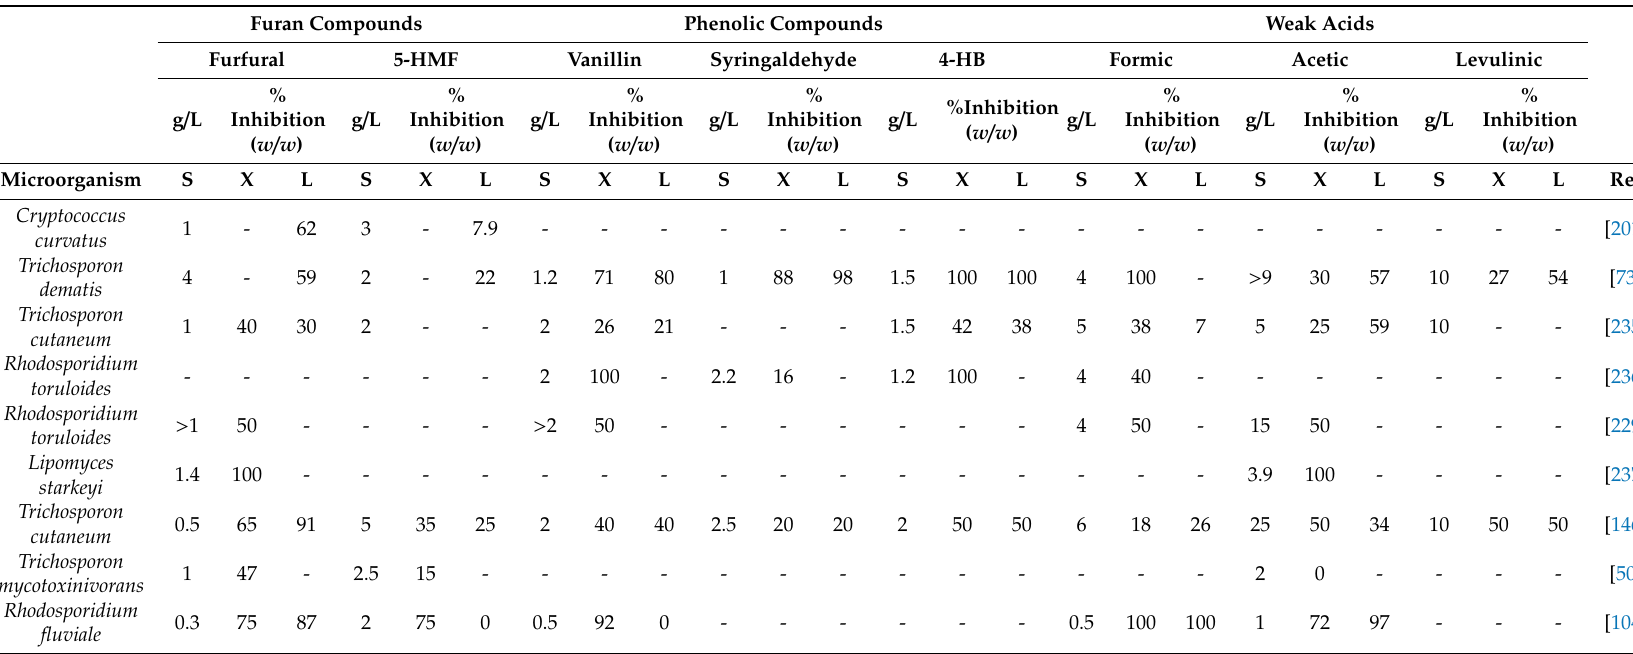
Table 3. Inhibition of growth and lipid production by oleaginous microorganisms due to the inhibitors generated during the pretreatment of lignocellulosic biomass. Furan Compounds Phenolic Compounds Weak Acids Furfural 5-HMF Vanillin